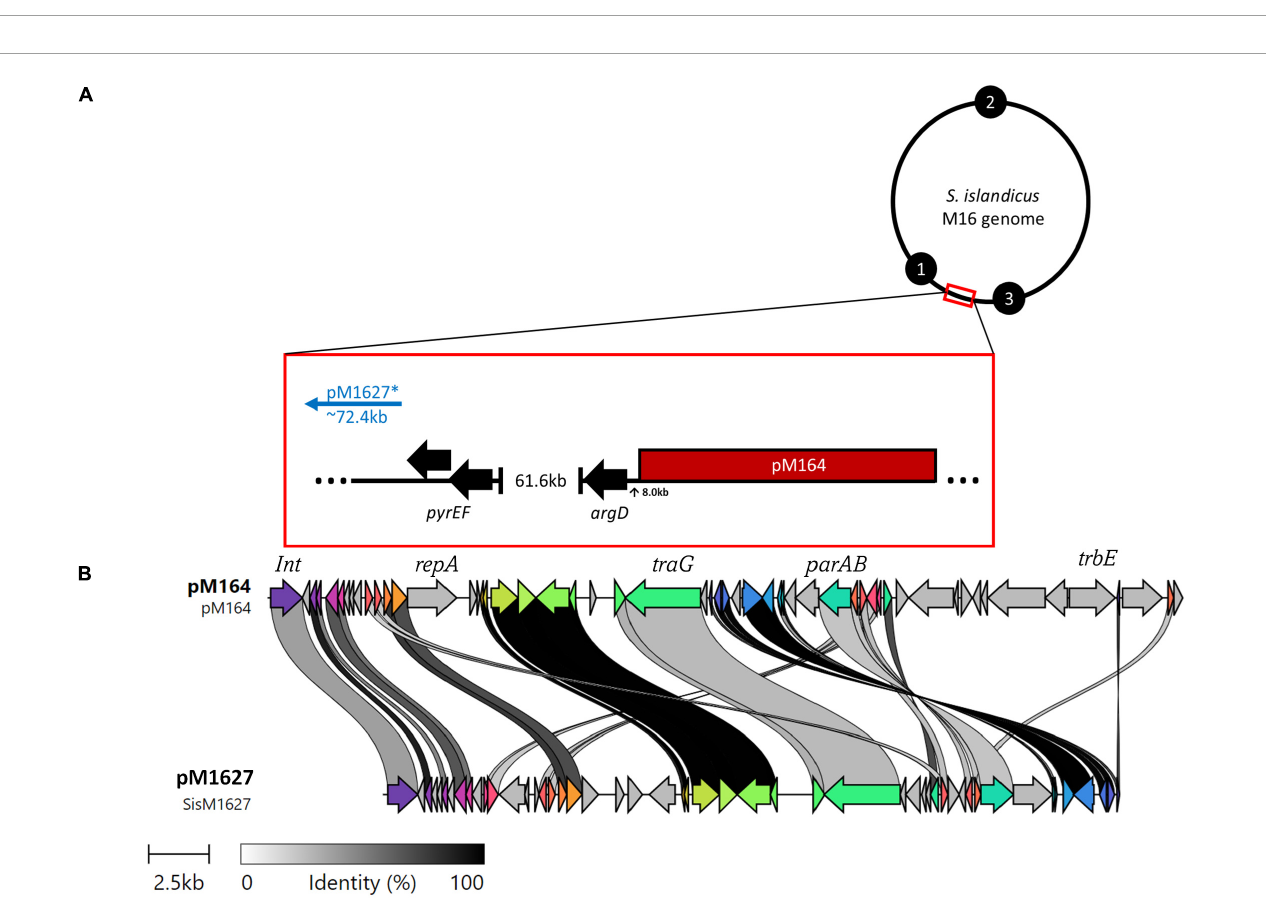
FIGURE2 Recombination frequencies of Red species isolates and Blue species representative (M.16.27) in mating assays with the tester strain, RJW004. White bars represent the recombinant frequency of argD recombinants, while black bars represent the recombinant frequency of (cid:49) pyrEF recombinants. Error bars represent highest and lowest replicate for each assay, ∗ represents a p -value of < 0.05 when compared to M.16.4